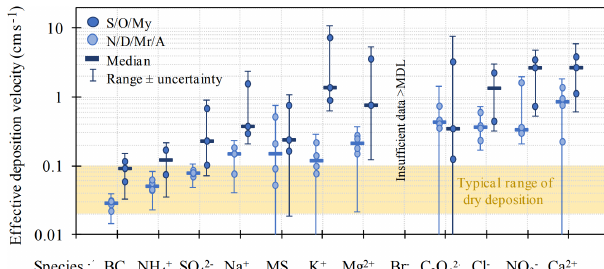
Figure 13. The monthly average (circles) effective deposition ve- locity of different chemical species to snow at Alert during 2014– 2015. Median values (bars) are also shown. The effective deposi- tion velocity encompasses both wet and dry deposition processes. In general, the warmer months have higher deposition velocities than the colder months, likely due to enhanced wet deposition in the former. Figure from Macdonald et al.